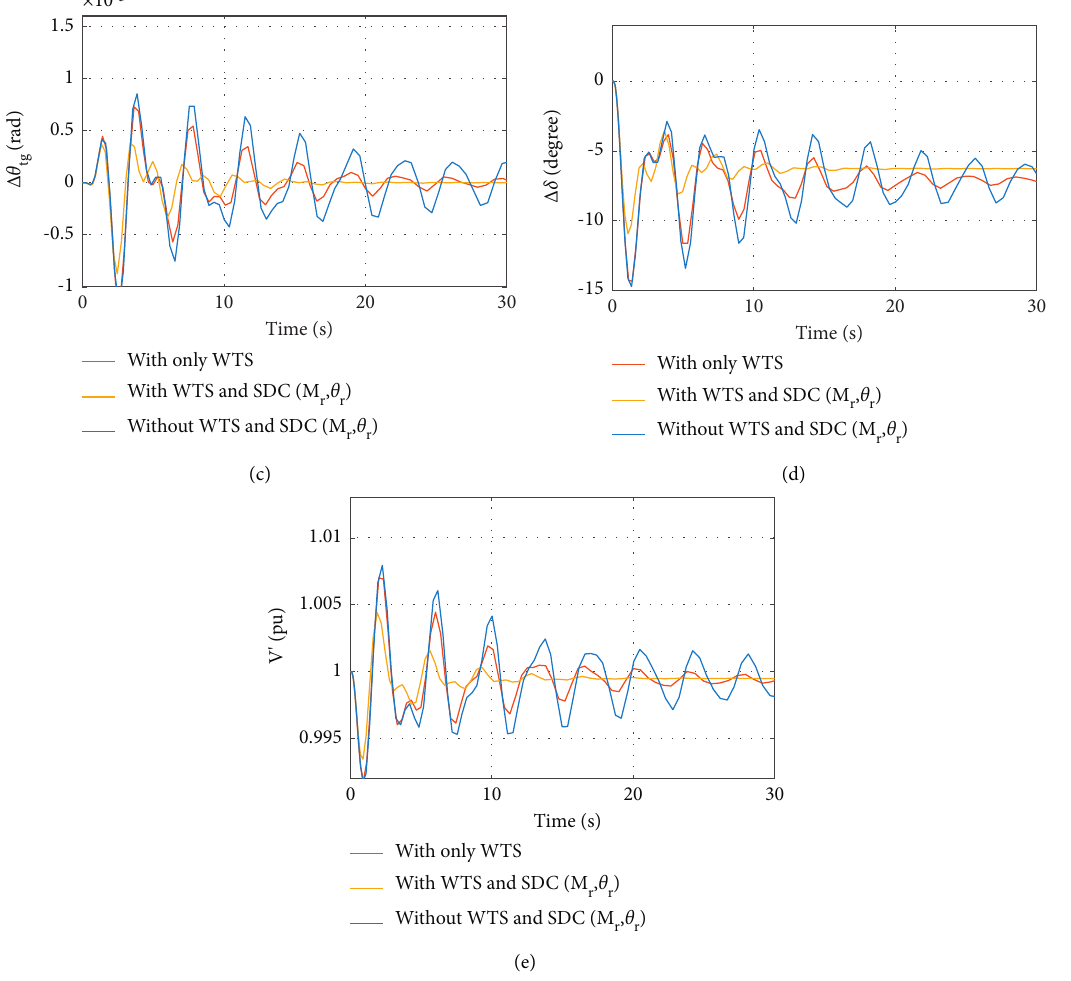
w ≈ 12m/s). (b) The rotor speed deviation in CPP (